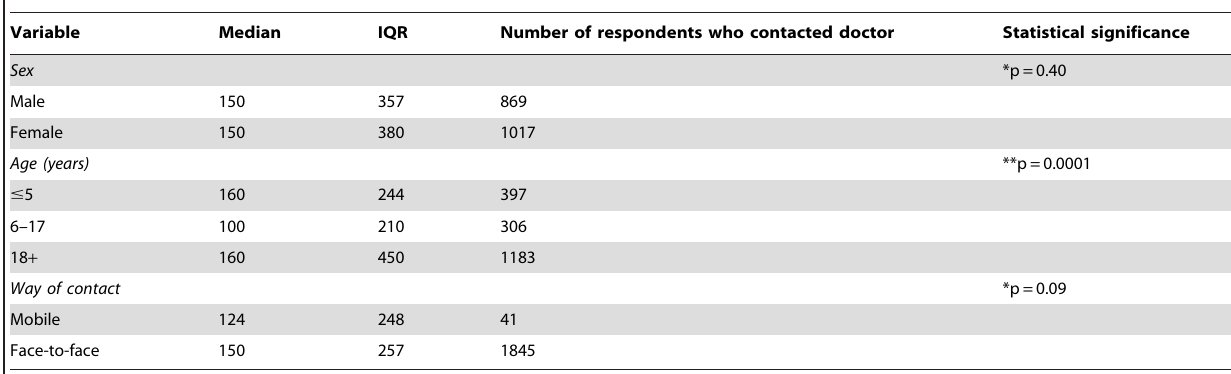
Table 7. Cost of treatment by background characteristics.